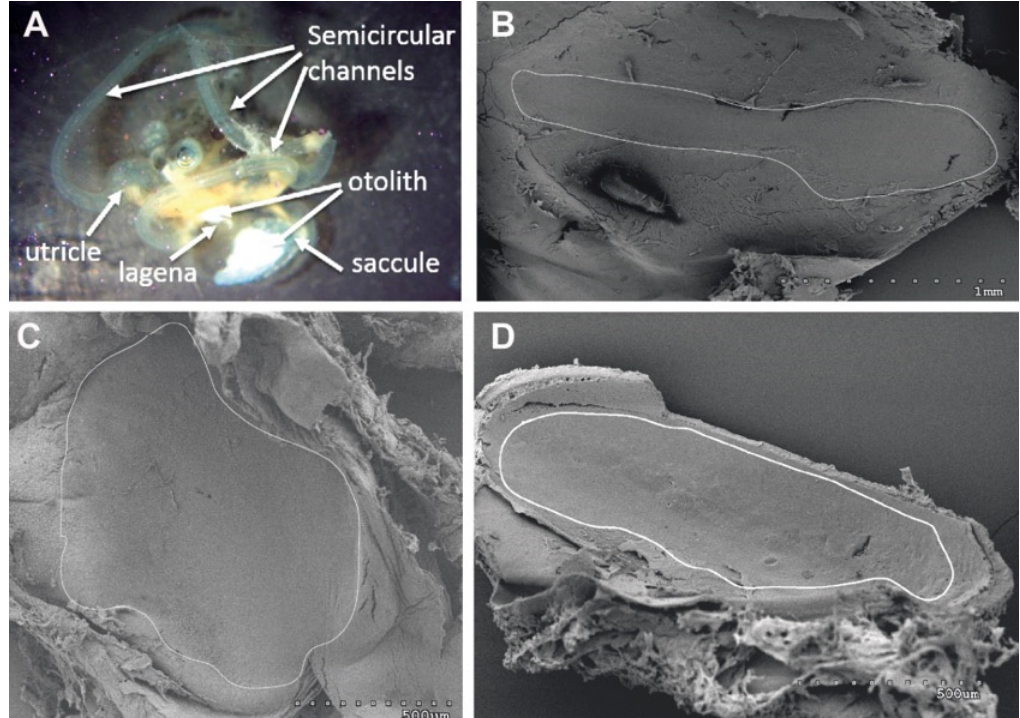
Figure 5. ( A ) LM (light microscopy). ( B – D ): SEM (scanning electron microscopy). Salmon inner ear. ( A ) The location of the three sensory epithelia and the three semicircular channels in the salmon inner ear is visible. ( B ) White line encloses the saccule sensory epithelium. ( C ) White line encloses the utricle sensory epithelium. ( D ) White line encloses the lagena sen- sory epithelium. Scale bar: ( B ) = 1 mm. ( C , D ) = 500 µm.